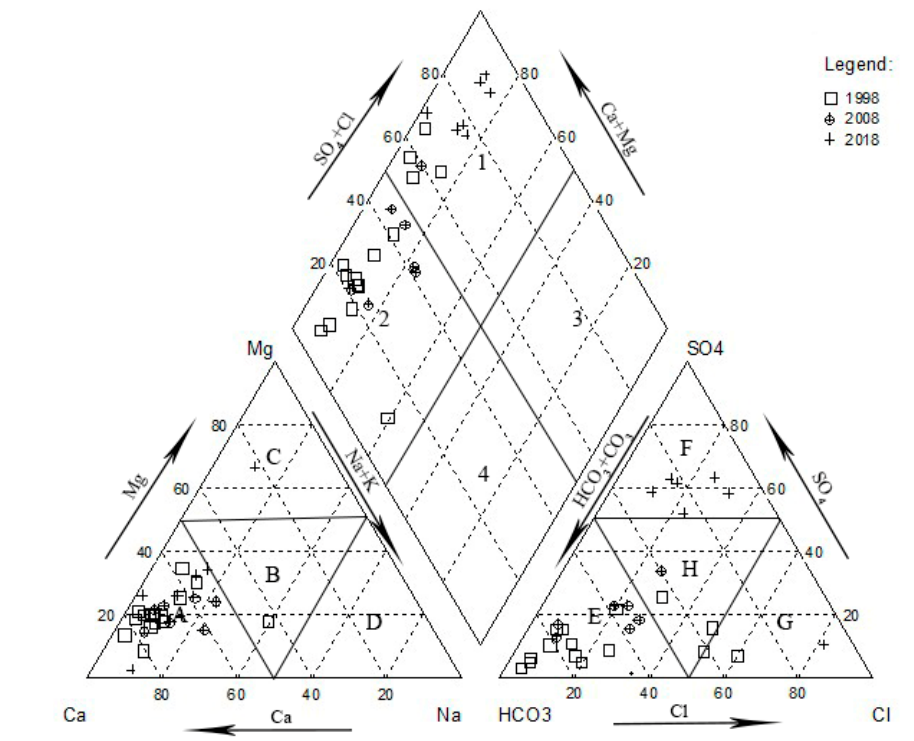
Figure 2. Representative Piper plot for annual groundwater quality.